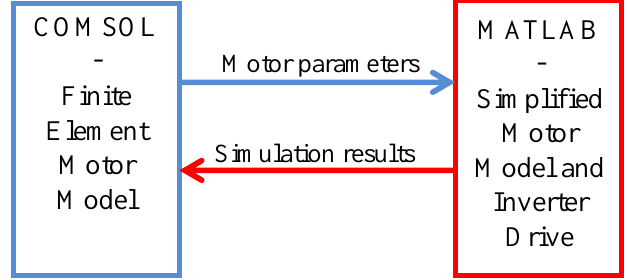
Fig. 1. The scheme of the described modeling